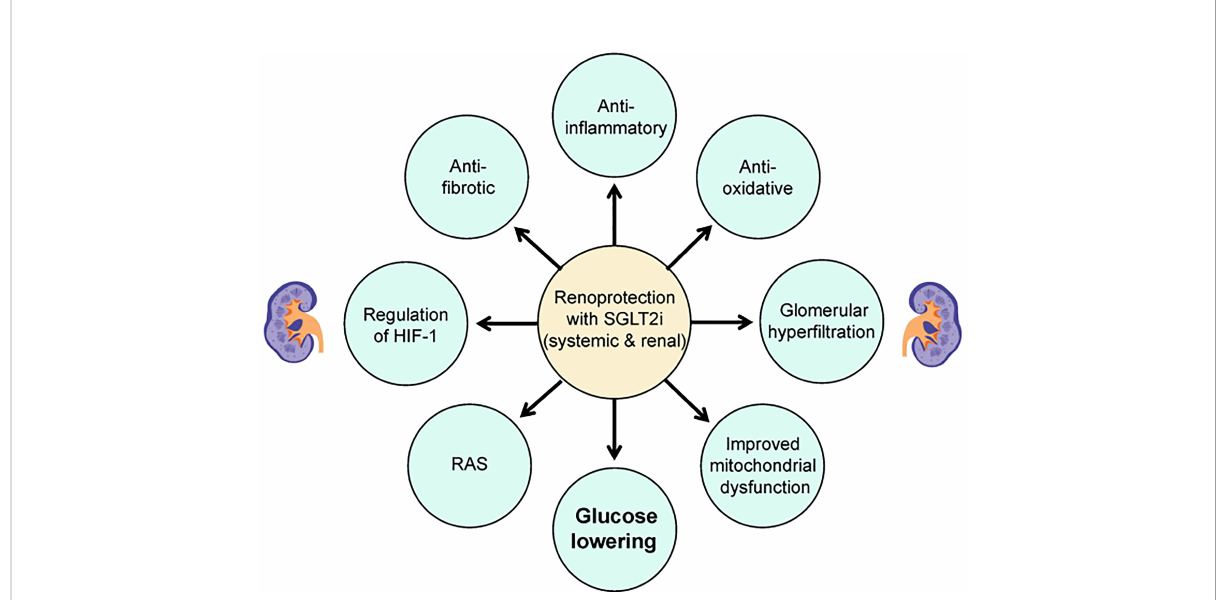
FIGURE 1 Potential mechanisms of renoprotective effects of SGLT2i in patients with type 2 diabetes. HIF-1, hypoxia-inducible factor 1; SGLT2i, sodium- glucose cotransporter-2 inhibitors; RAS, renin-angiotensin